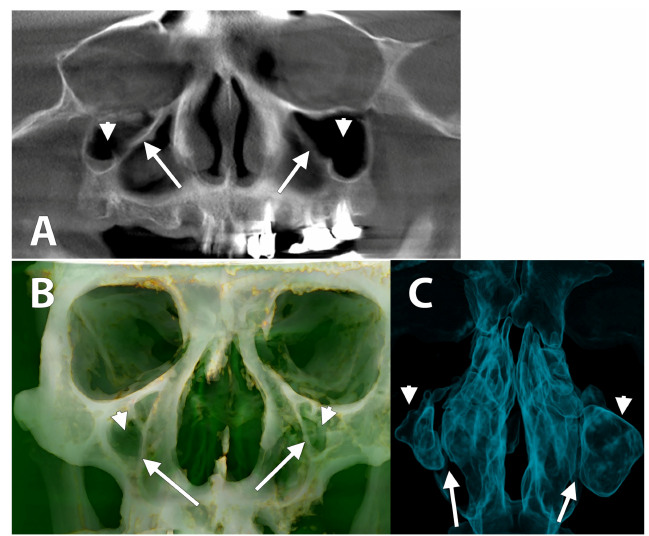
Figure 1. Bilateral maxillary sinus hypoplasia, anterior views. ( A ) Digital orthopantomogram; ( B ) three- dimensional volume rendering (Bone+Skin Filter); ( C ) three-dimensional volume rendering (Airways Filter). Hypoplastic maxillary sinuses (arrowheads) and the lateral nasal walls (arrows) are indicated.